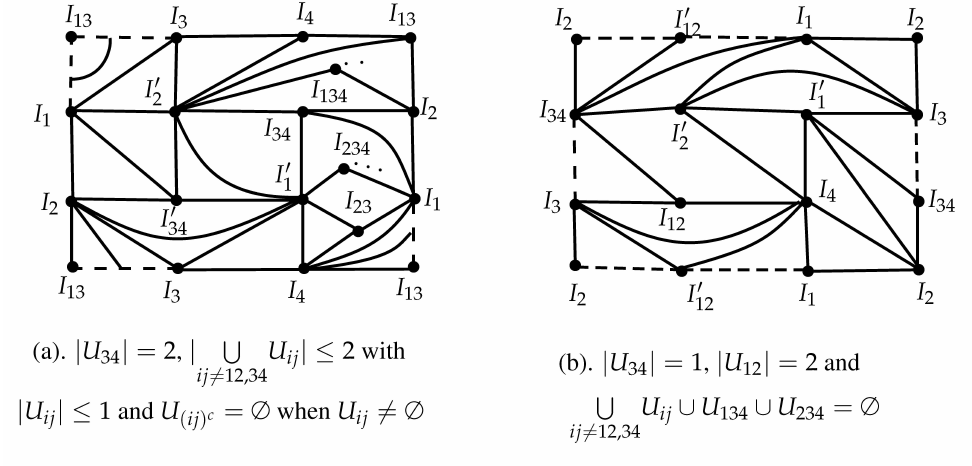
∪ 4 U n | = 6 with | U 1 | = n = 1